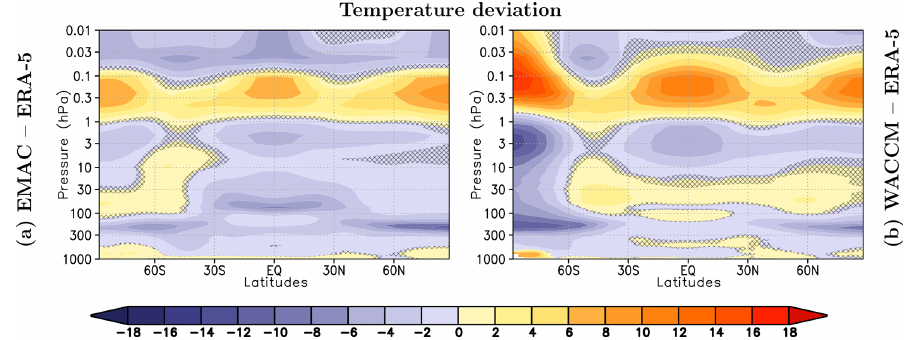
Figure 7. Annual mean temperature deviation of EMAC and WACCM to ERA-5 climatology. (a) EMAC – ERA-5 and (b) WACCM – ERA- 5 climatology. The ensemble mean for each CCM consists of the solar minimum reference simulation (included five times in the ensemble mean) and the five simulations of the solar maximum. The ERA-5 data consist of annual mean data from 1982 to 2018. Grey hatching masks areas where differences do not pass a test for statistical significance ( p > 5%), for differences relative to